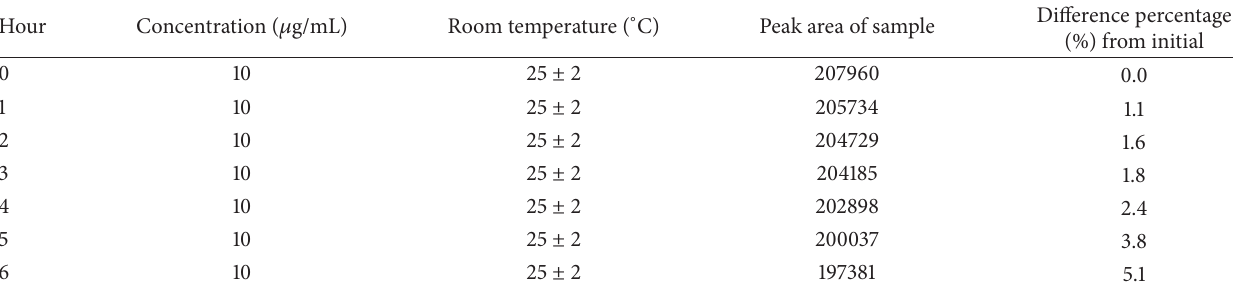
Table 5: Stability of analytical sample solution.